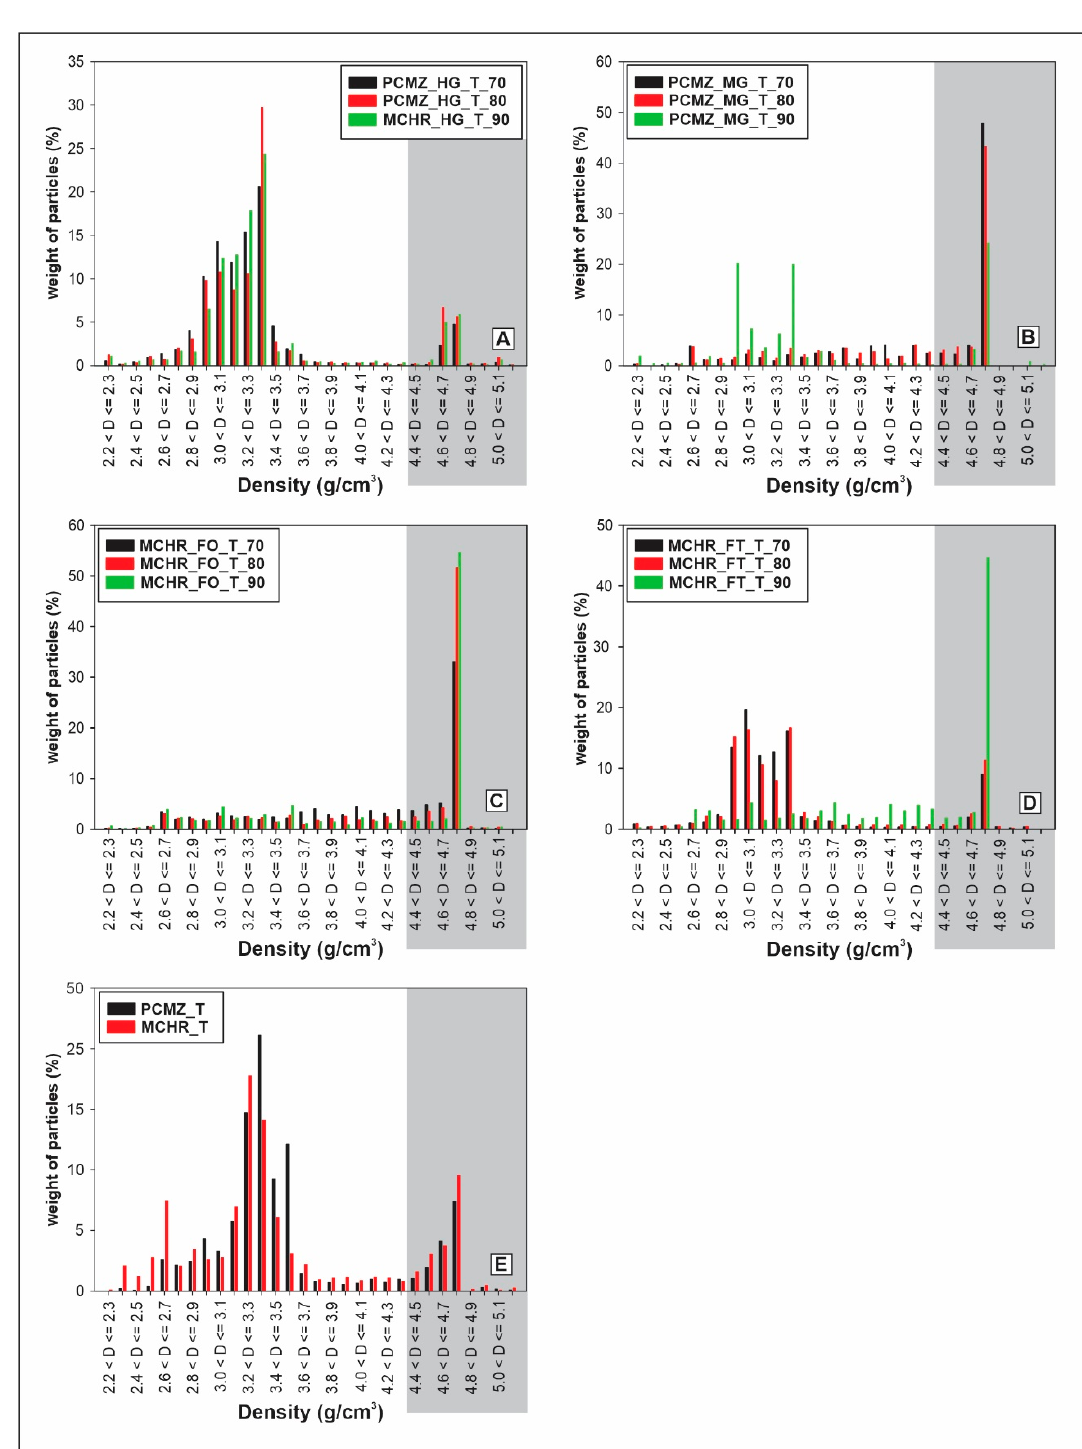
Figure 9. Particle density distribution plots for the tailings samples. ( A ) PCMZ_HG. ( B ) PCMZ_MG. ( C ) MCHR_FO. ( D ) MCHR_FT. ( E ) PCMZ and MCHR samples from the concentrator plant.